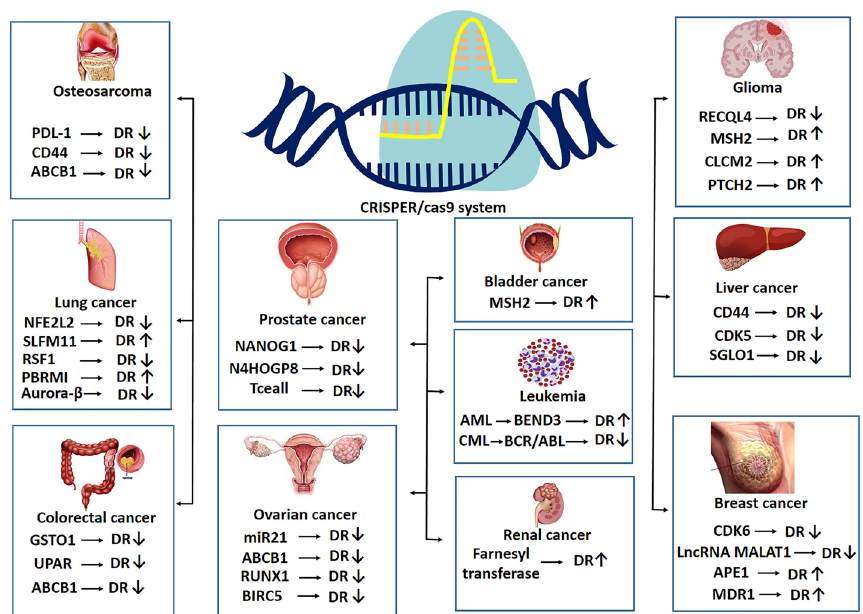
Fig. 3 Identified genes involved in drug resistance and effects of CRISPR/Cas9‑mediated inhibition on drug resistance. DR drug